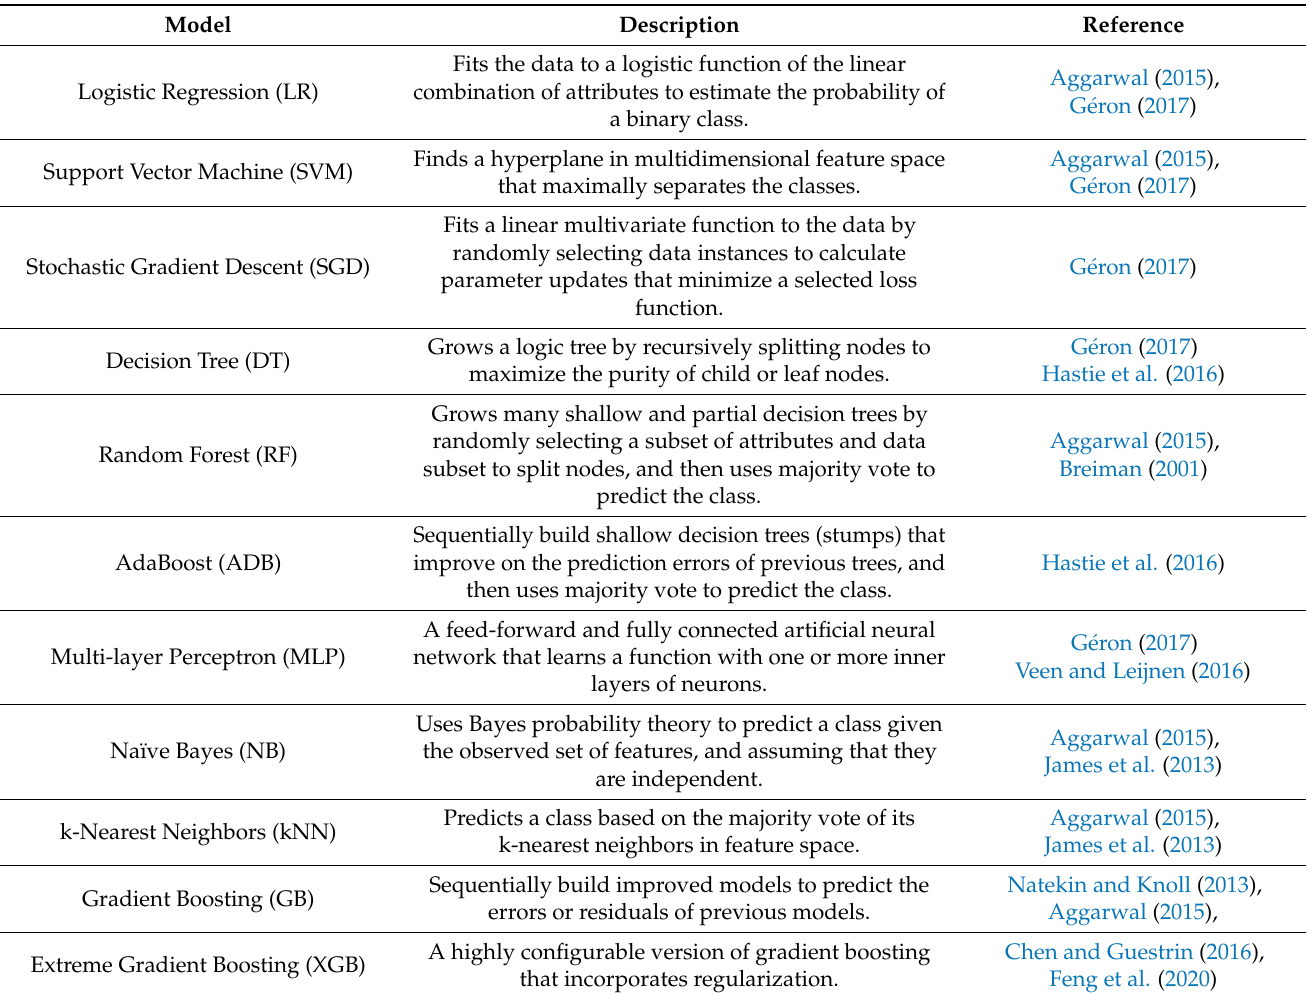
Table 1. Machine learning models applied in the procedural